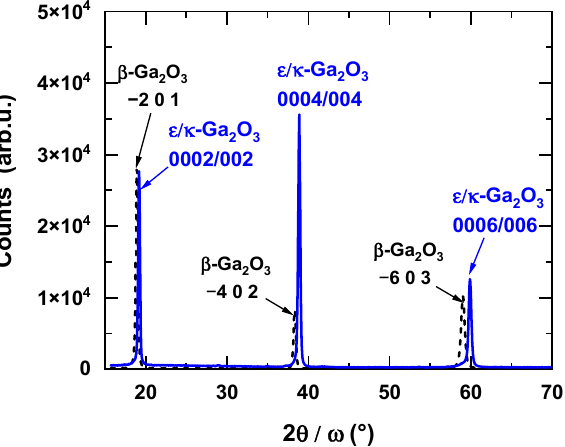
Figure 1. Comparison of symmetric 2 θ / ω scans of β -phase and ε / κ -phase Ga 2 O 3 films grown by LI-MOCVD. Details on the growth of β -Ga 2 O 3 films can be found in Ref. [27]. In the following, the subscripts h (hexagonal) and o (orthorhombic) will be used to label the lattice parameters and the diffraction indices of ε -Ga 2 O 3 and κ -Ga 2 O 3 , respectively. Comparing the in-plane lattice parameters a h = 0.29036 nm, a o = 0.50463 nm, and b o = 0.87020 nm of ε and